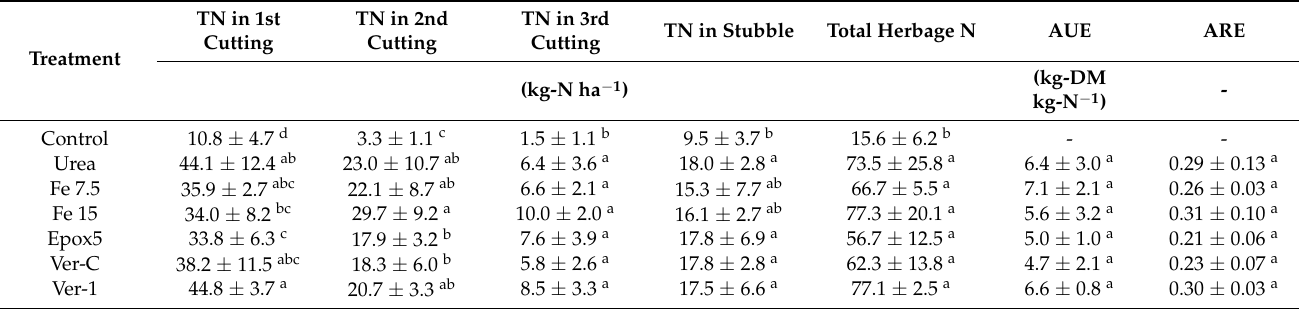
Table 2. The herbage nitrogen and nitrogen utilisation efficiencies of the different